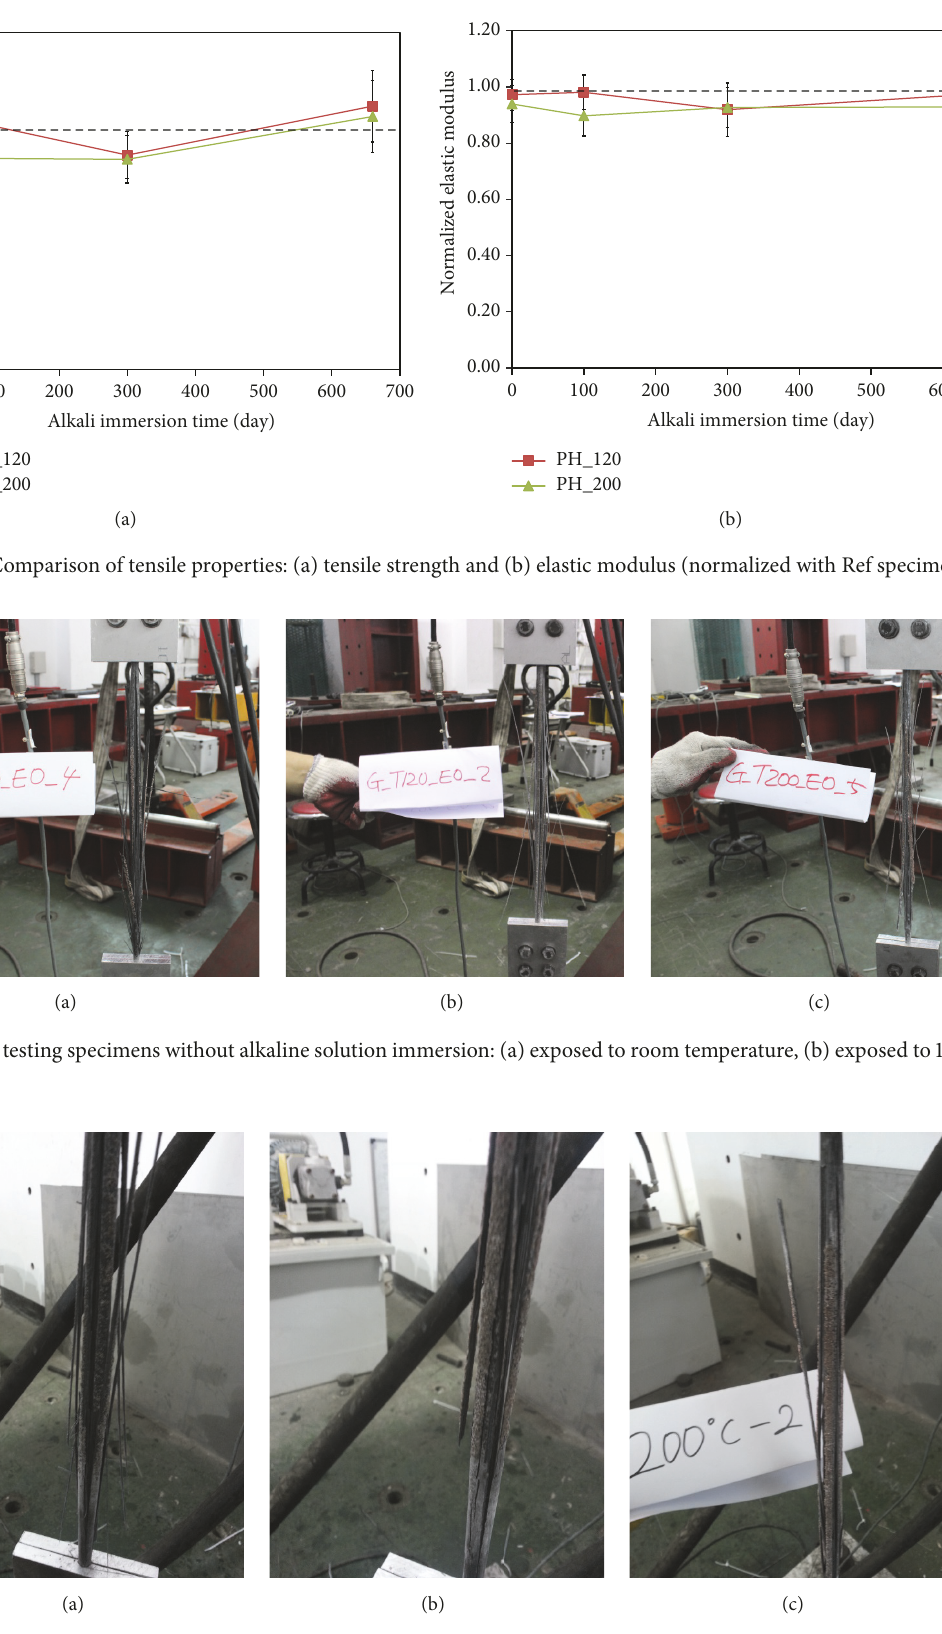
Figure 13: Failure of specimens immersed into alkaline solution for 300 days: (a) exposed to room temperature, (b) exposed to 120 ∘ C, and (c) exposed to 200 ∘